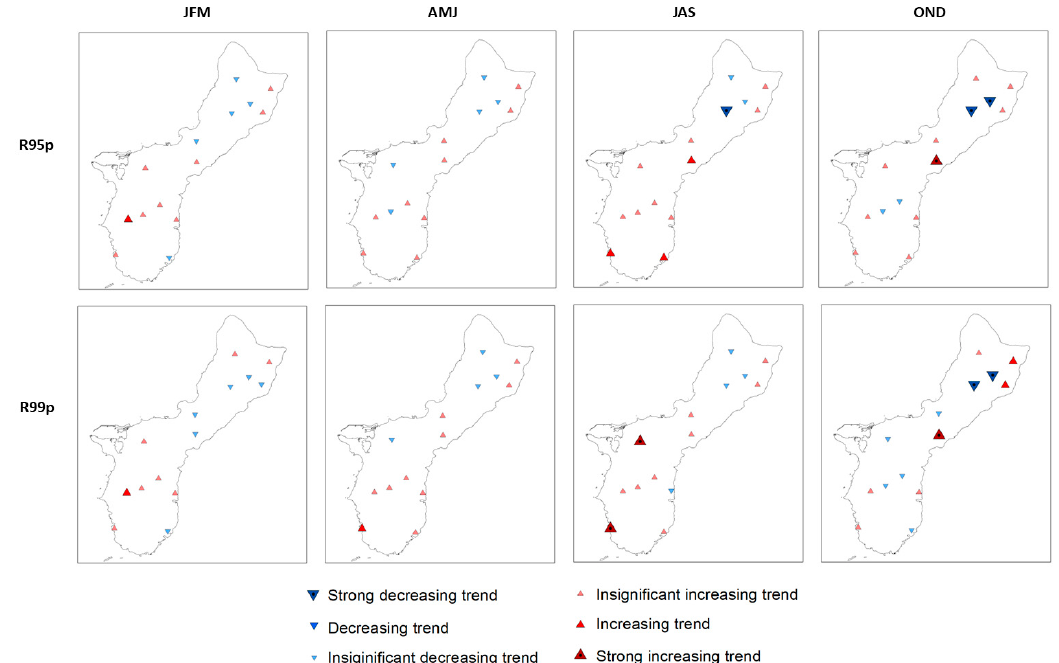
Figure 8. Spatial distributions of seasonal trends of the extreme rainfall indices: the 95th percentile of total precipitation (R95p, mm) and the 99th percentile of total precipitation (R99p, mm). Columns represent each season, and rows represent each index.